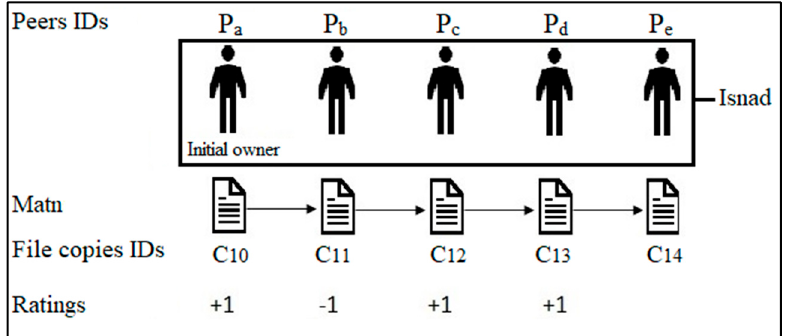
Figure 2. Example of a file chain.